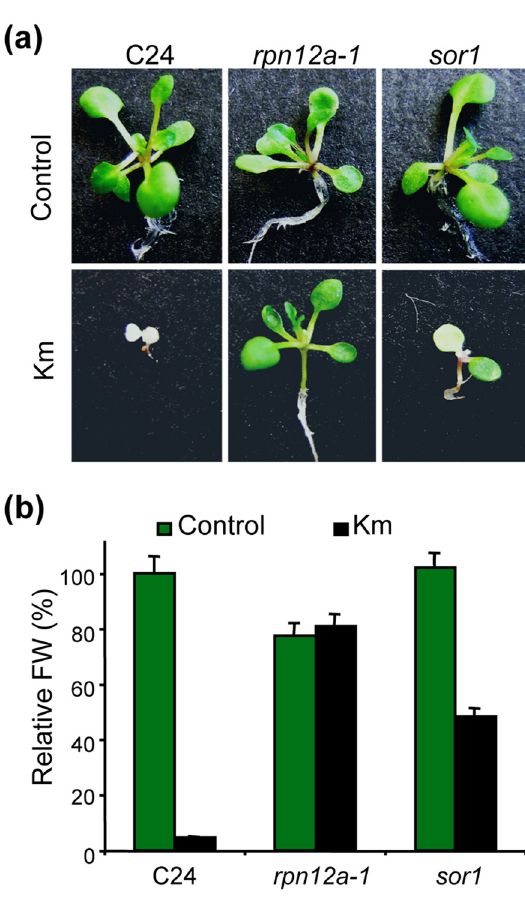
Figure 2. The sor1 mutation leads to a partial loss of kanamycin resistance. ( a ) Wild-type (C24), r pn12a‑1 and sor1 seeds were sown and grown on MS/2 media containing 35 µg/ml kanamycin (Km). Representative plants were photographed after two weeks